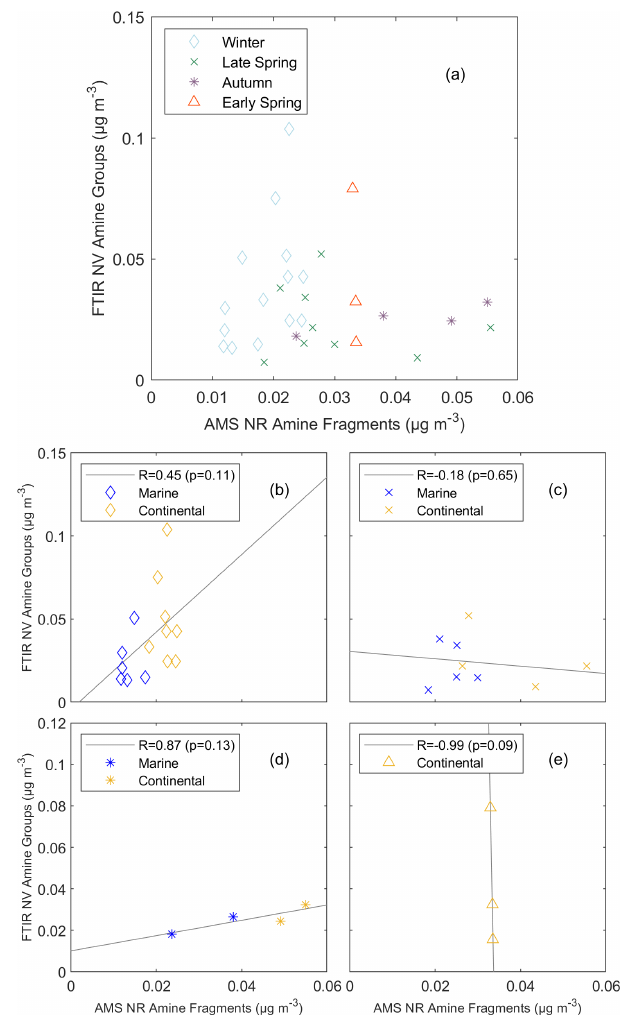
Figure 2. Scatterplot of (above detection limit – ADL) FTIR NV amine groups in particles with diameters < 1µm versus AMS NR amine fragments for (a) all cruises ( ρ = 0 . 02, p = 0 . 18), (b) winter, (c) late spring, (d) autumn, and (e) early spring. Markers represent each cruise: open diamond – winter, crosses – late spring, asterisk – autumn, and open triangle – early spring. Marker colors represent the air mass type: blue – marine and yellow – continental. The solid gray lines are the lines of best fit obtained using an ordinary least squares regression. A two-tailed t test is used to estimate p